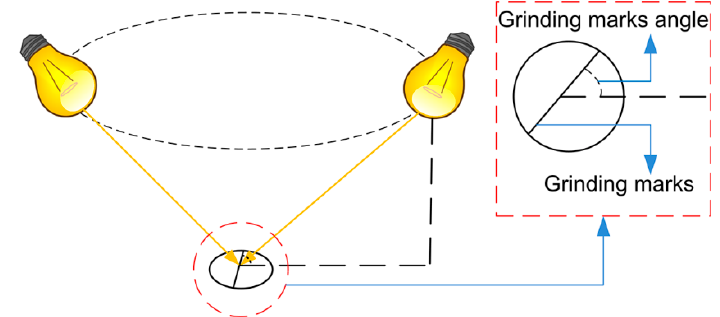
Figure 9. The angle of grinding marks. Table 2. Formula for calculating grinding marks angle.